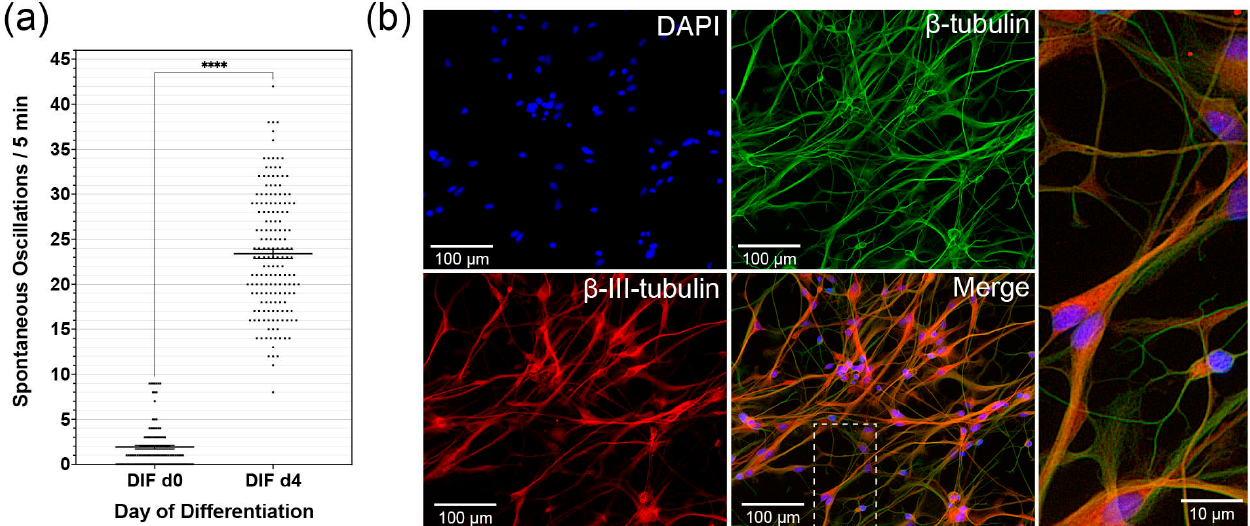
Figure 1. Spontaneous calcium oscillations during CN NSC differentiation. ( a ) Analysis of the spontaneous calcium oscillations by calcium imaging from DIF d0 to d4. ( b ) Representative microphotographs of the immunocytological analysis on DIF d4: DAPI stains the cell nuclei, b-tubulin the cytoskeleton, β -III-tubulin identifies differentiated neurons. Data are shown as mean ± standard error of the mean; asterisks indicate the significance level: **** p < 0.0001.